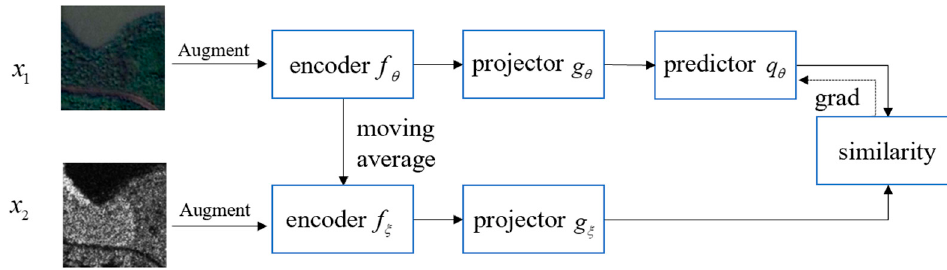
Figure 5. Structure of BYOL with SAR-optical images.